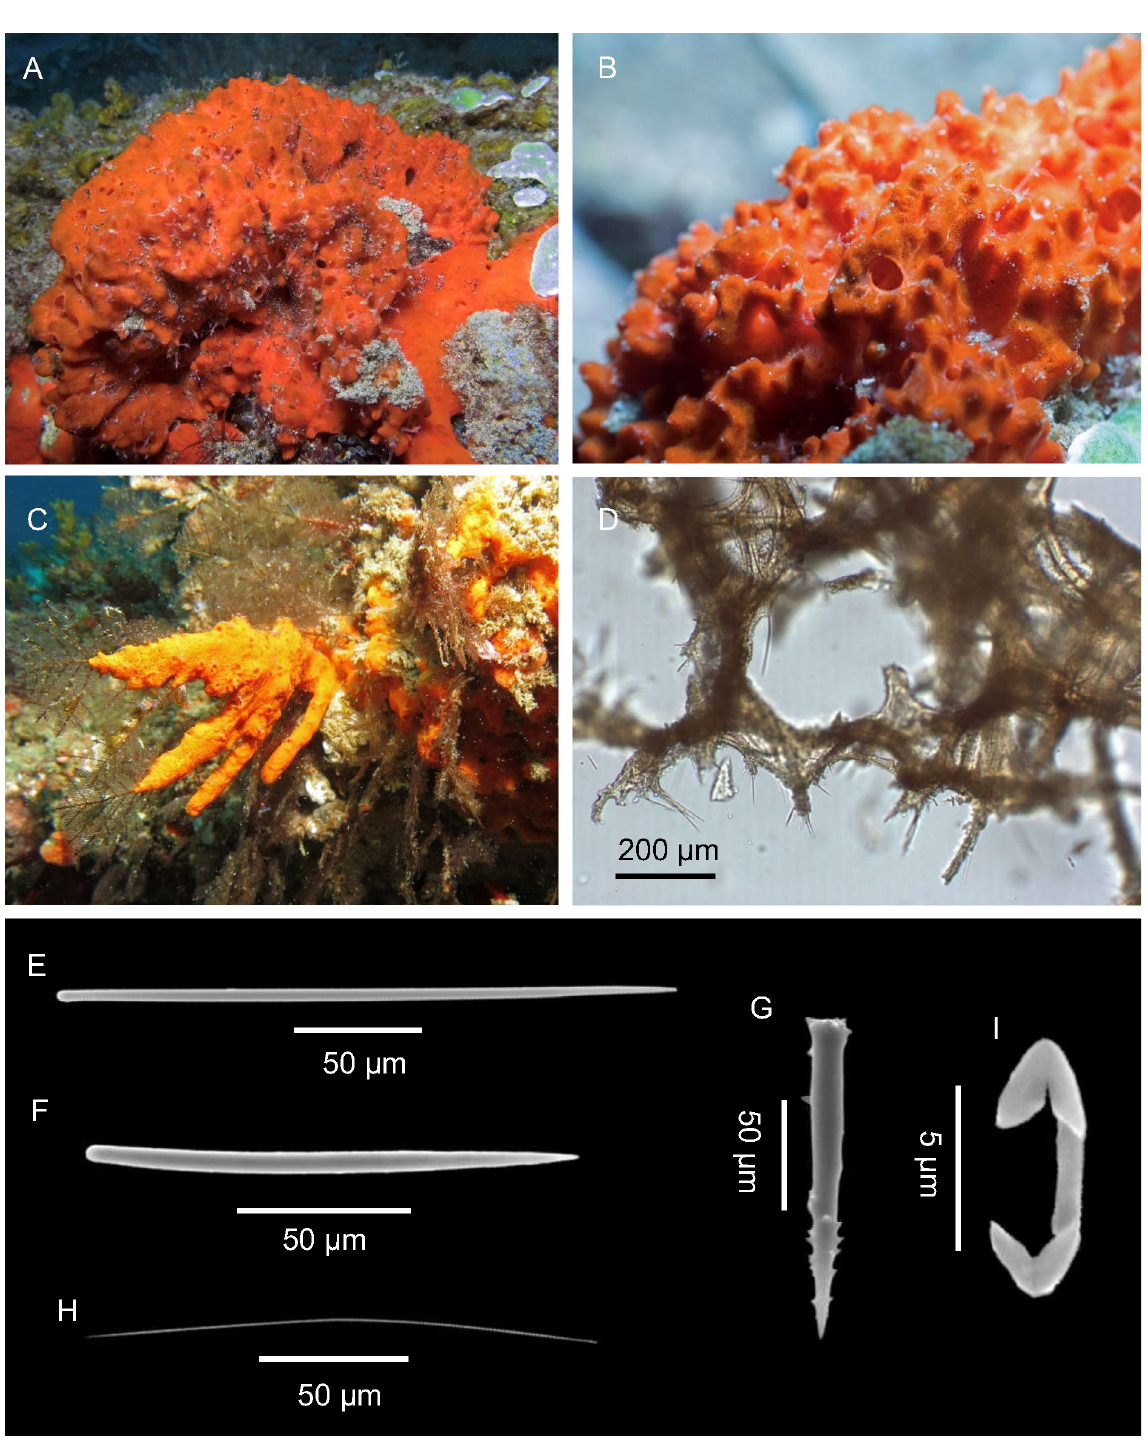
Fig. 21. Clathria ( Thalysias ) hirsuta Hooper & Levi, 1993. A–B . Massive specimen PO78 in situ . C . Digitiform specimen PO10 in situ . D . Choanosome. E . S mooth and straight style. F . Smooth and slightly curved style. G . Straight acanthostyles. H . Raphidiform toxa. I . Palmate